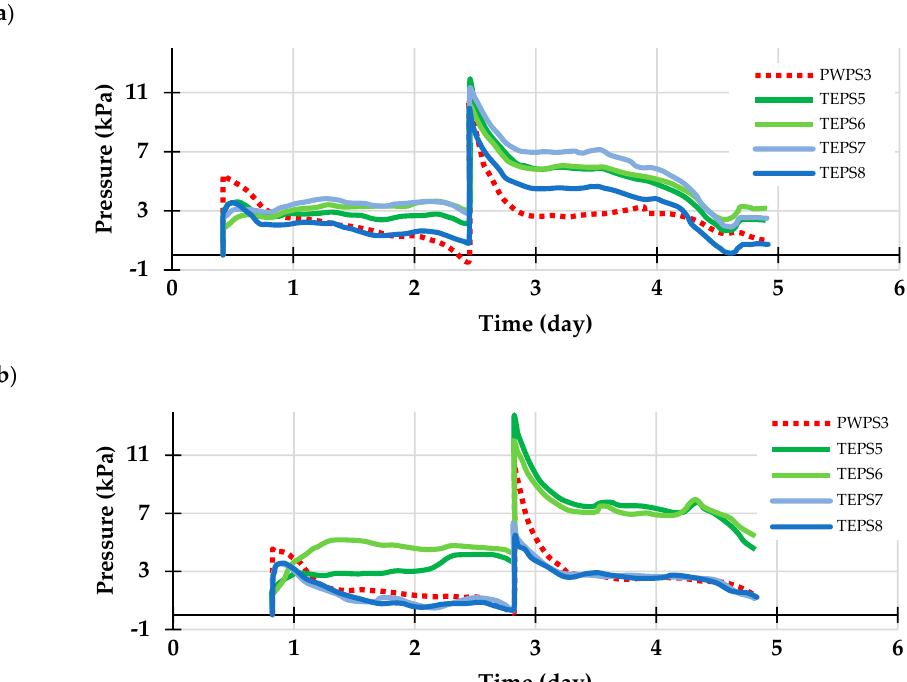
Figure 8. The backfill pressure at 20 cm above the base stope: ( a ) for the GSD #1 barricade, and ( b ) for the GSD #5 barricade.